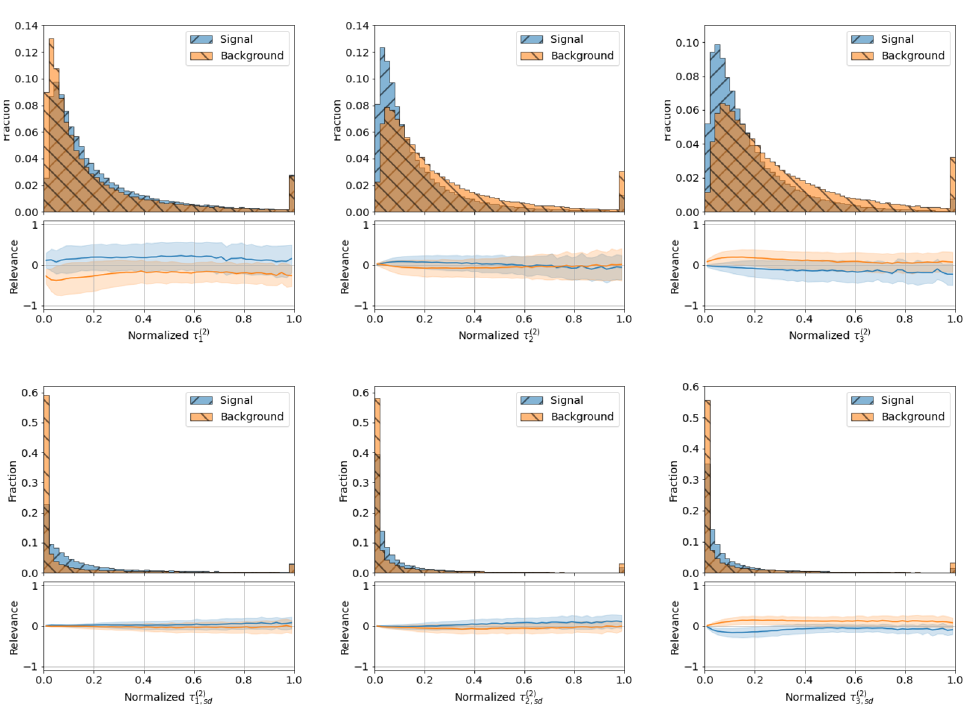
Figure 29. Histograms with profiles of normalized LRP